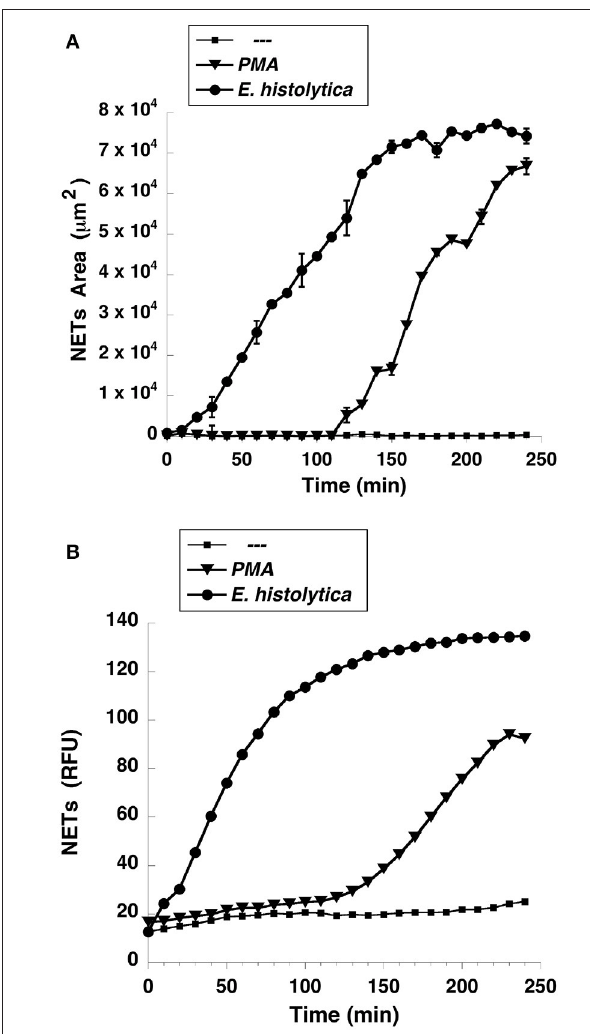
FIGURE 3 | Entamoeba histolytica induce NETs formation faster than PMA. Human neutrophils were left untreated (—), or were stimulated with 20 nM phorbol 12-myristate 13-acetate (PMA), or with E. histolytica, and then incubated for 4h. The relative amount of NETs was estimated from (A) live cell images and reported as area of external DNA or (B) from SYTOX ® Green fluorescence in relative fluorescent units (RFU) every 10min. Data are mean ± SEM of three experiments done in triplicates.